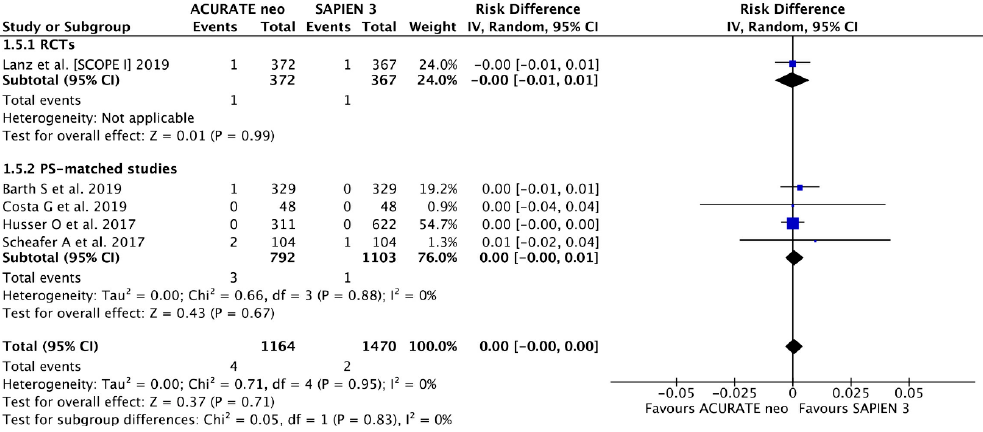
Figure A8. Clinical outcomes. Individual and summary risk ratios with corresponding 95% confidence intervals for the comparison of ACURATE neo and SAPIEN 3 in the analysis of periprocedural myocardial infarction taking into account “0 events”.